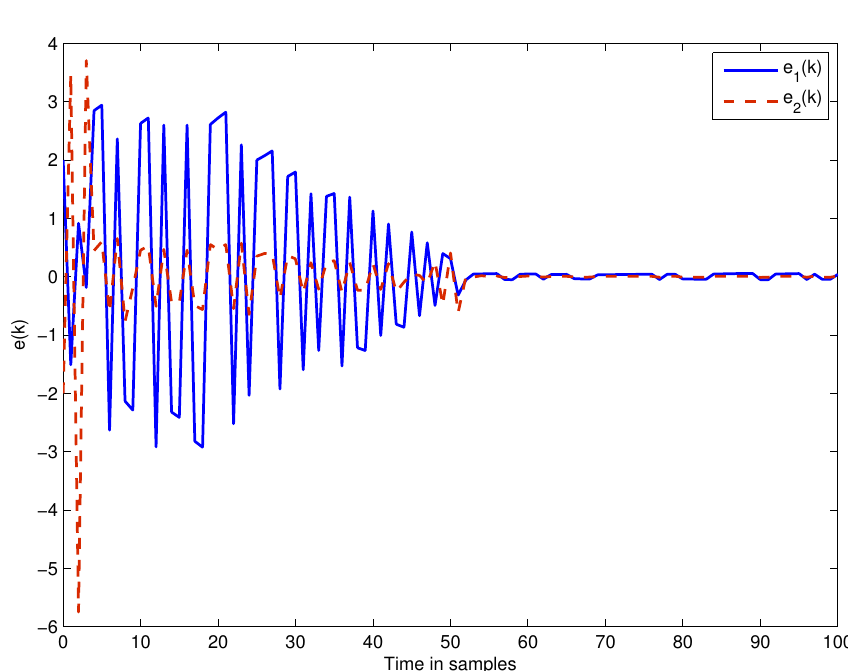
Figure 5. State response of error system by PMS observer.